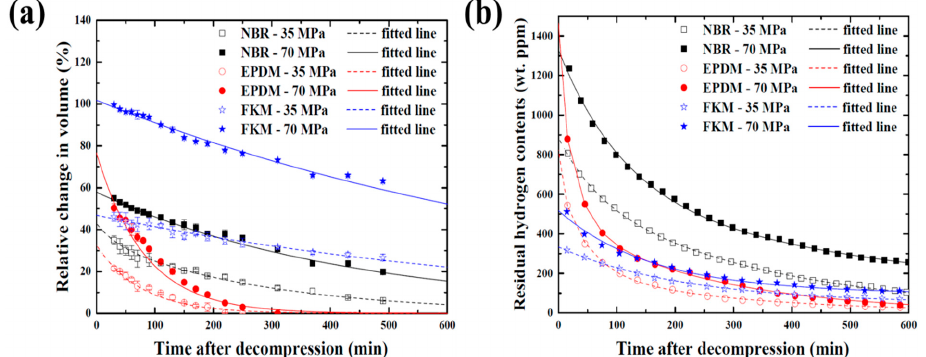
Figure 4. Results of ( a ) volume swelling and ( b ) hydrogen content.